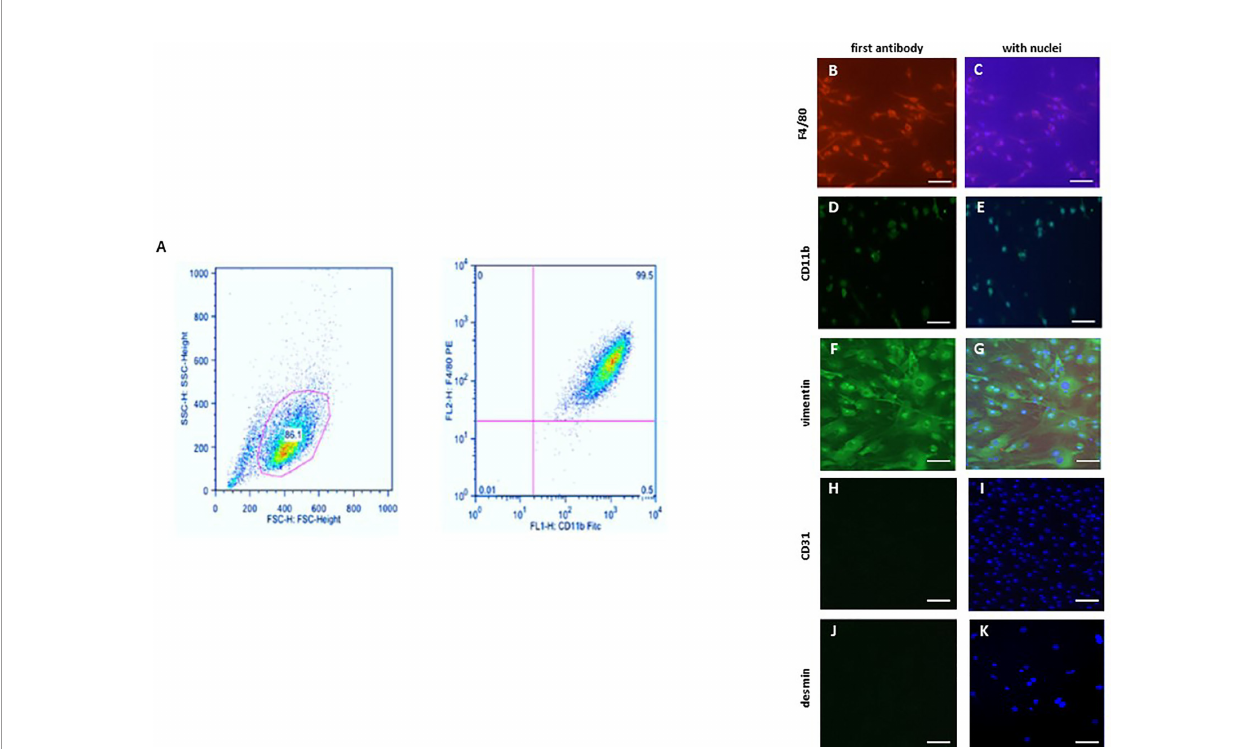
FIGURE 1 | Characterization of bone marrow derived macrophages (BMMs) and cardiac fi broblasts. (A) Flow cytometric analysis of the F4/80 and CD11b expression in BMMs. Representative images of BMMs stained against (B, C) F4/80 and (D, E) CD11b. Representative images of cardiac fi broblasts stained against (F, G) vimentin, (H, I) CD31 (endothelial marker; negative control) and (J, K) desmin (smooth muscle marker; negative control). Nuclei were stained with DAPI (C, E, G, I, K) Magni fi cation: 40x; scale bar: 50 µm. Data are representative of 3 independent experiments with similar